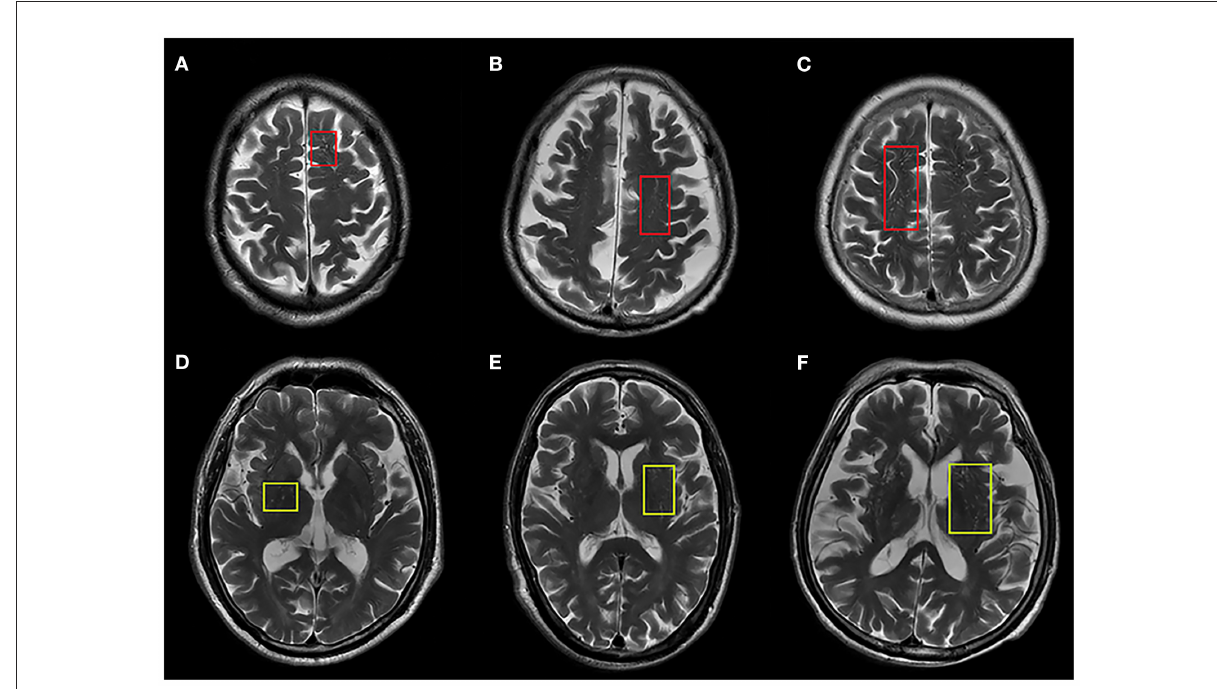
FIGURE1 Representative axial T2-weighted images of enlarged PVS in centrum semiovale (ePVS-CSO) and basal ganglia (ePVS-BG). (A–C) Indicate ePVS-CSO with red squares corresponding to degree of severity. (D–F) Indicate ePVS-BG with yellow squares corresponding to degree of